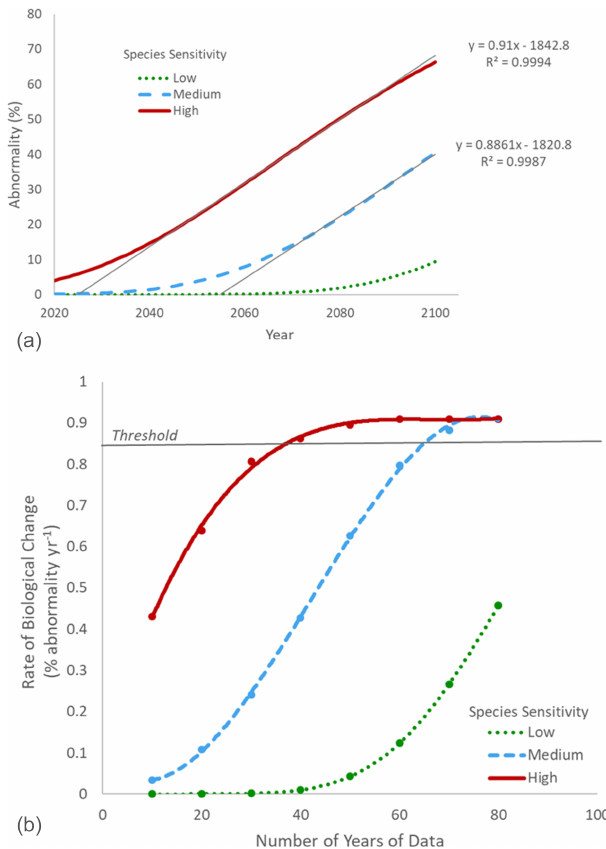
Figure 6. (a) Projection of larval abnormality under a rate of chem- ical change of 0.0044pH units per year (Andersson et al., 2008) for organisms with three different levels of sensitivity to pH (low, medium, high). The rate of biological change was estimated for each scenario as the slope of the significant regression between time and abnormality (%) over the linear phase of the curve. For the species with low sensitivity, the linear phase was not reached, and it was not possible to calculate the rate of biological change. (b) Re- lationship between the number of years of data for the biological monitoring and the calculated rate of biological change for three organisms with different levels of sensitivity to pH (low, medium, high). Sufficient years of data were considered to have been col- lected when the observed rate of biological change was above the 0.86 threshold (5% from the maximum rate of change of 0.91% of abnormality per